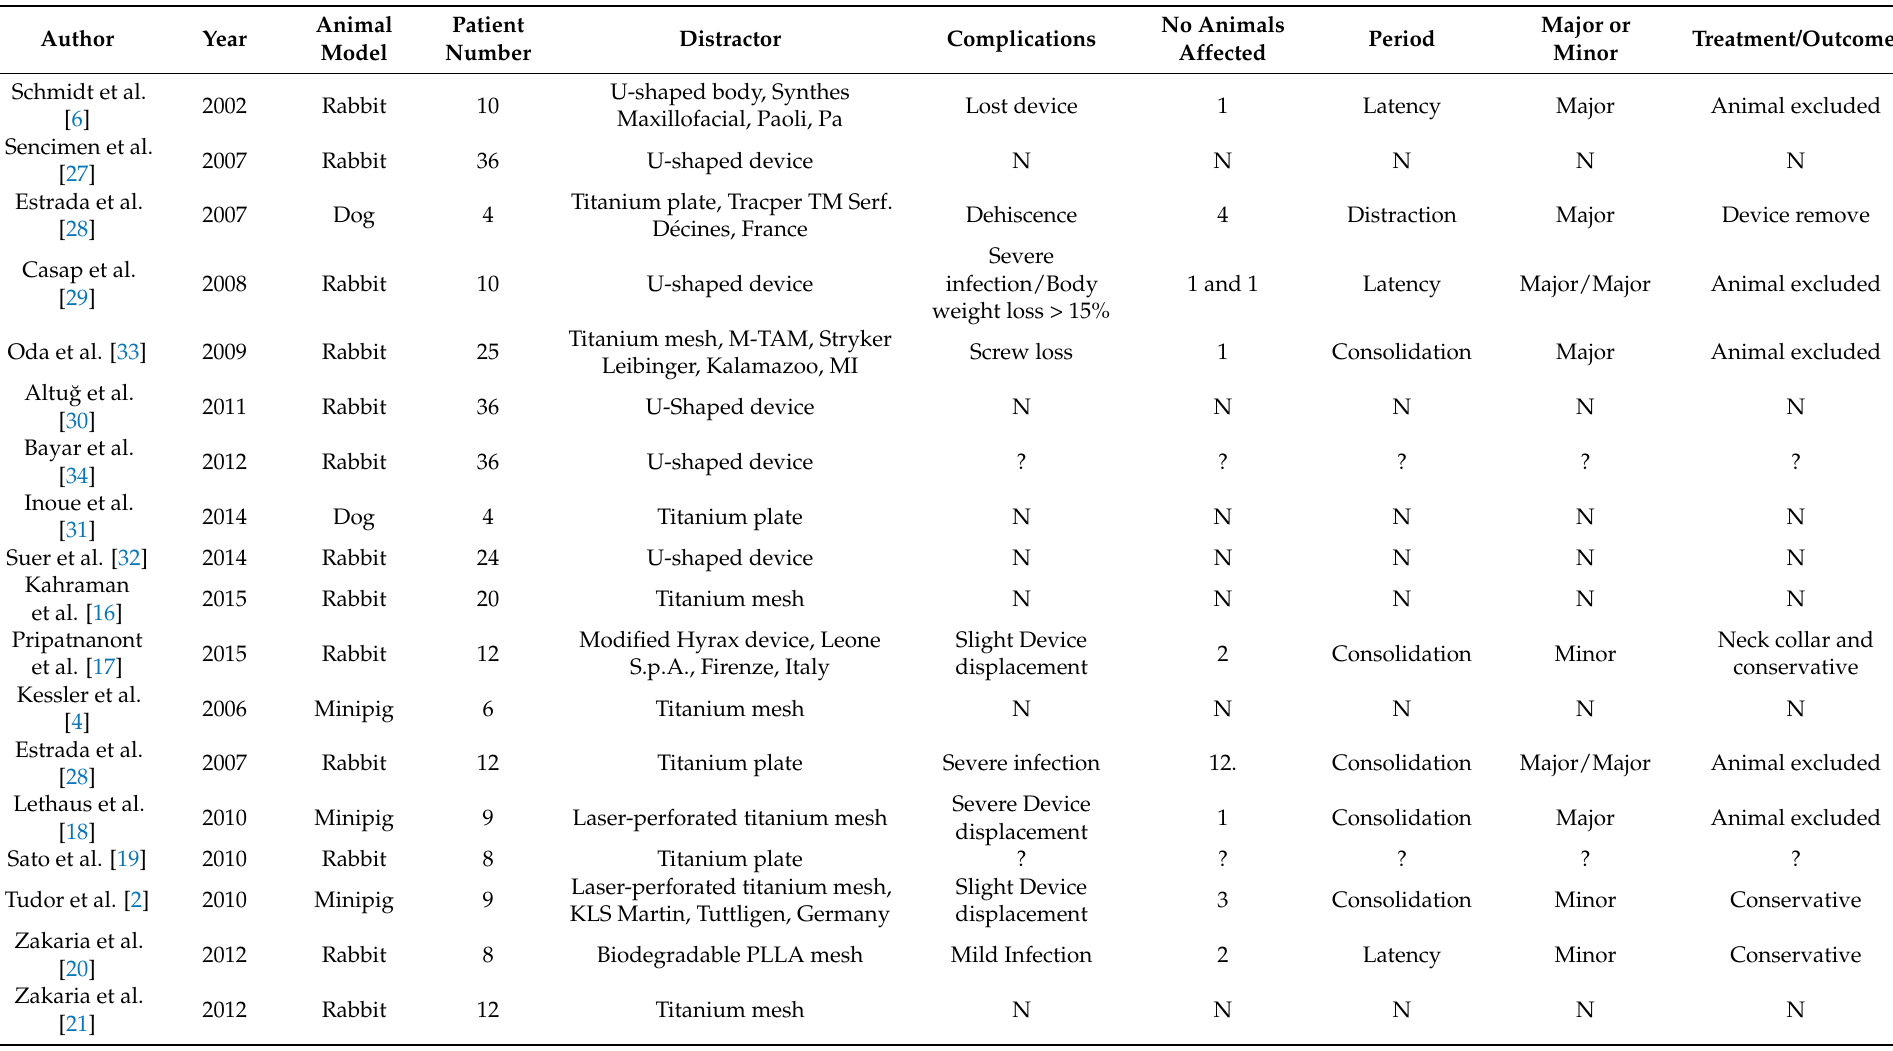
Table 3. Complications shown in the